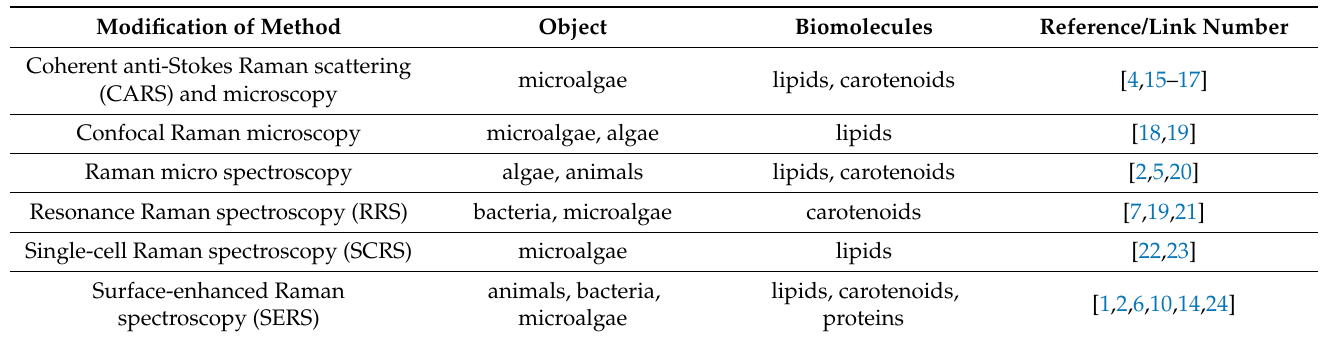
Table 1. The list of modifications of RS with details of the objects and molecules of interest with reference numbers of the papers used in the article.